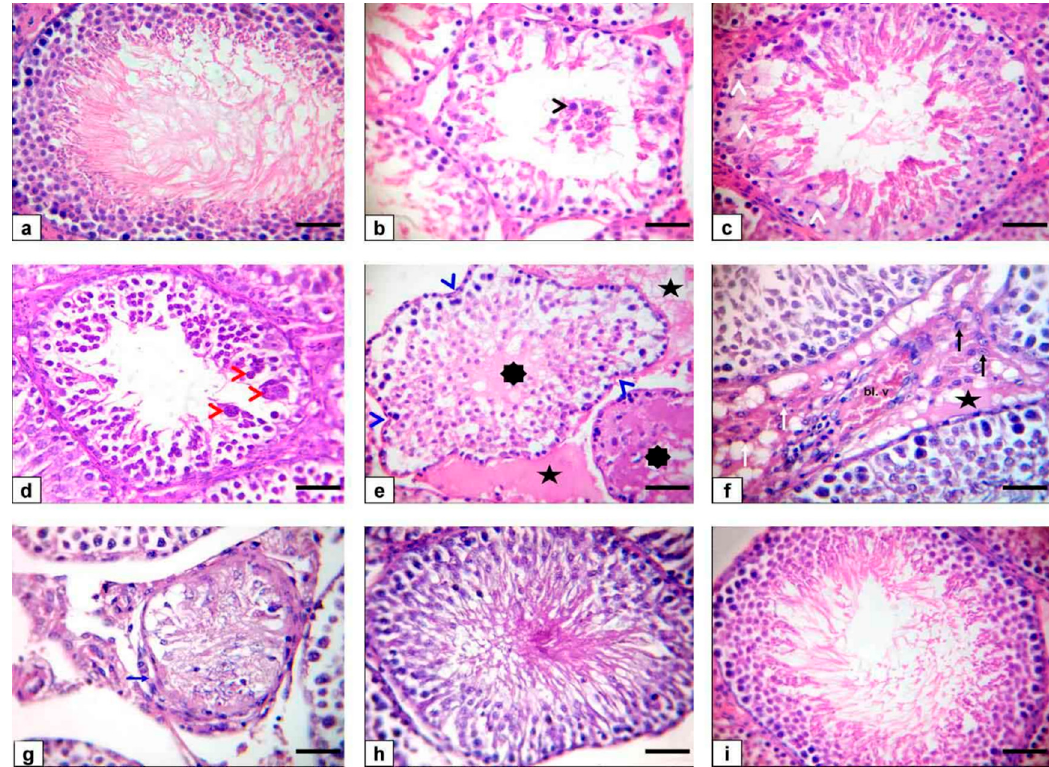
Figure 2. Photomicrograph of rat testes stained with HE. Bar = 50 µm. ( a ) Normal testes histoarchitecture of control rats ( b – g ) FPN-administered rats showing sloughing of the germinal epithelium in the lumen of seminiferous tubules (black arrowhead), fragmentation or necrosis of tubular epithelium (white arrowheads) with giant cell formations in the lumen of seminiferous tubules (red arrowheads), depletion of germinal cells and hyalinization of the luminal contents (asterisks) besides shrunken, buckled, and disorganized seminiferous tubules (blue arrowheads) as well as interstitial edema (stars), mild inflammatory cell infiltration (white arrows), mild hyperplasia of interstitial endocrine cells (black arrows) with congestion of the interstitial blood vessels (Bl. v), and finally atrophy of some seminiferous tubules (blue arrow). ( h ) FPN + BA 1 rats showing the normal histoarchitecture of seminiferous tubules with the presence of spermatids and spermatozoa in their lumen. ( i ) FPN + BA 2 rats showing normal histoarchitecture of seminiferous tubules.